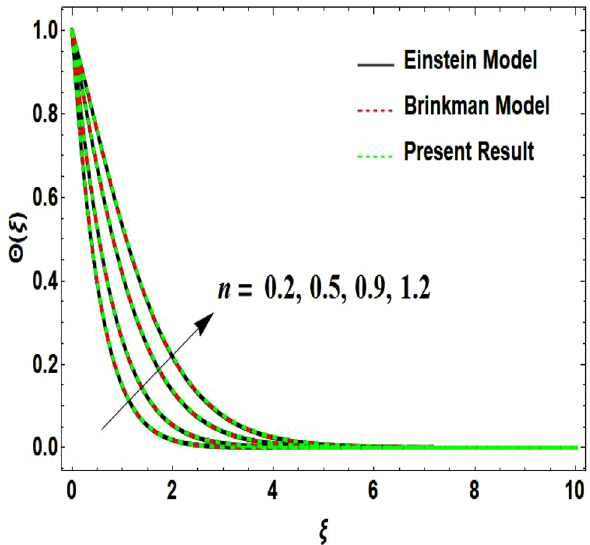
Figure 9. Temperature curve influenced by velocity power index parameter.